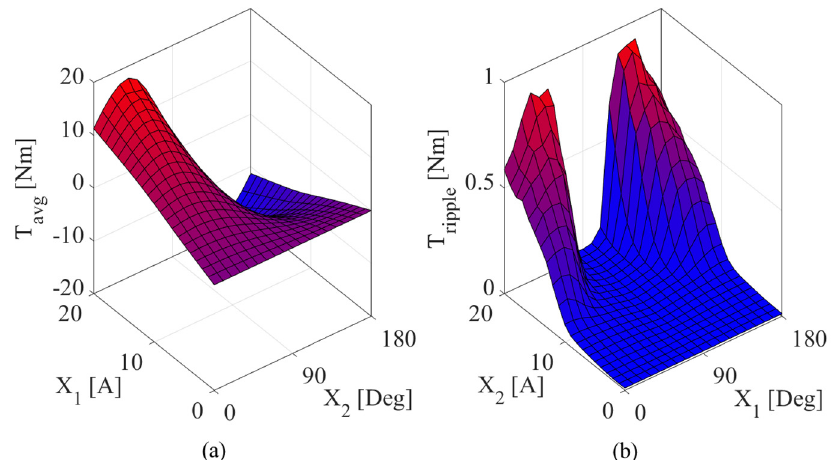
Figure 12. FEA results for torque performance of the Model-III: ( a ) Average Torque, and ( b ) Torque Ripple.